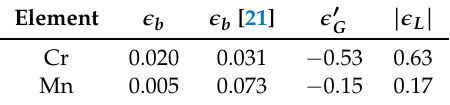
for PM FeCr 10–16 Mn 12–32 -base G